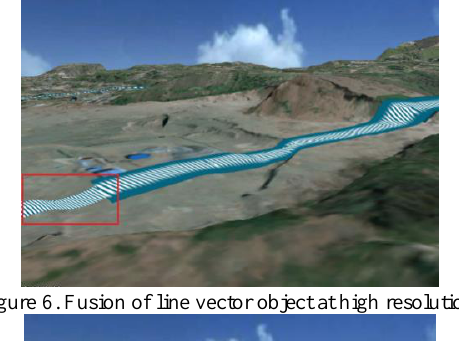
Figure 6. Fusion of line vector object at high resolutions